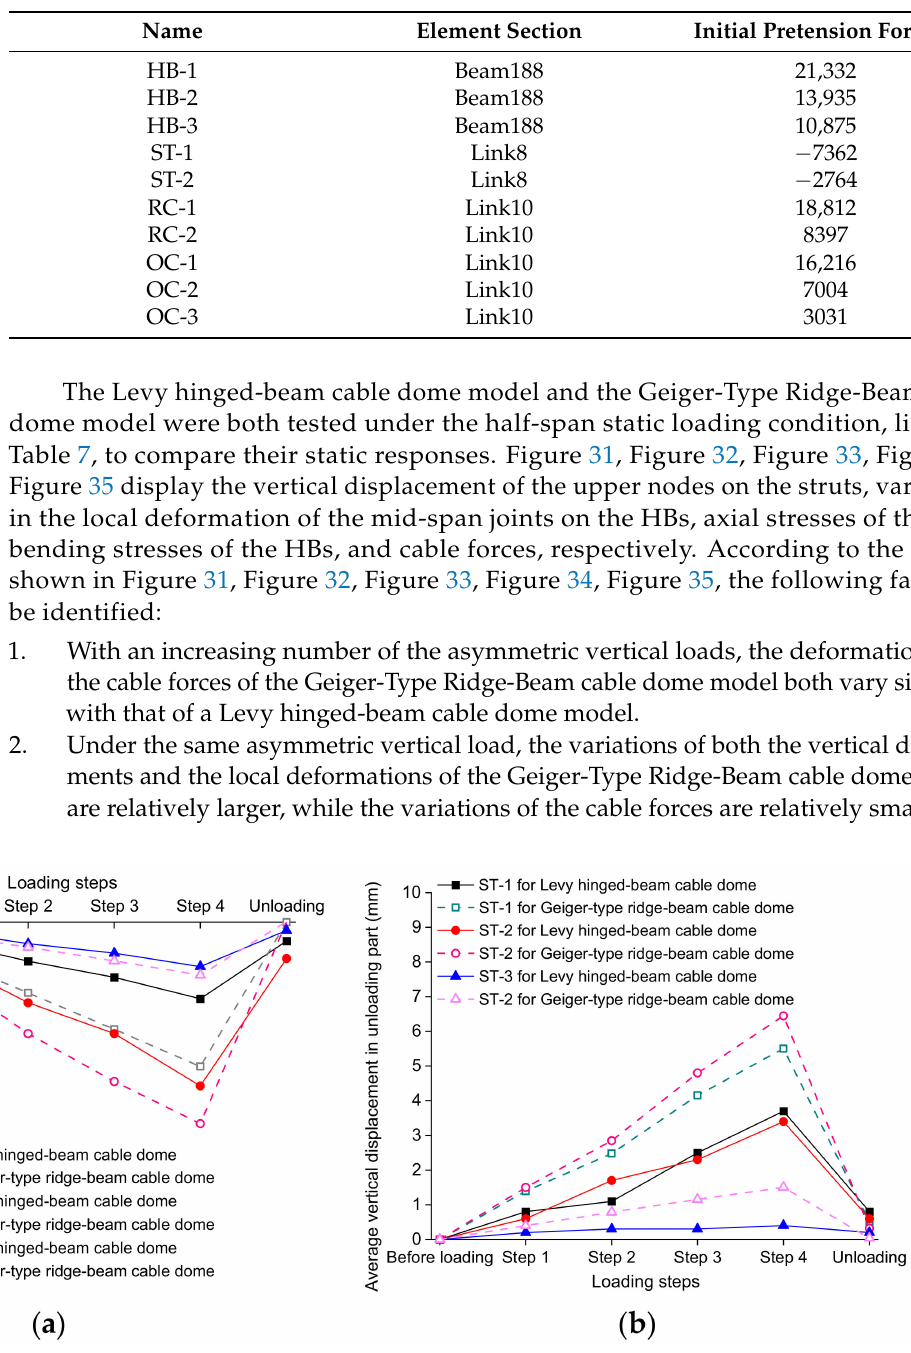
Table 8. Initial prestress of the Geiger-Type Ridge-Beam cable dome model.